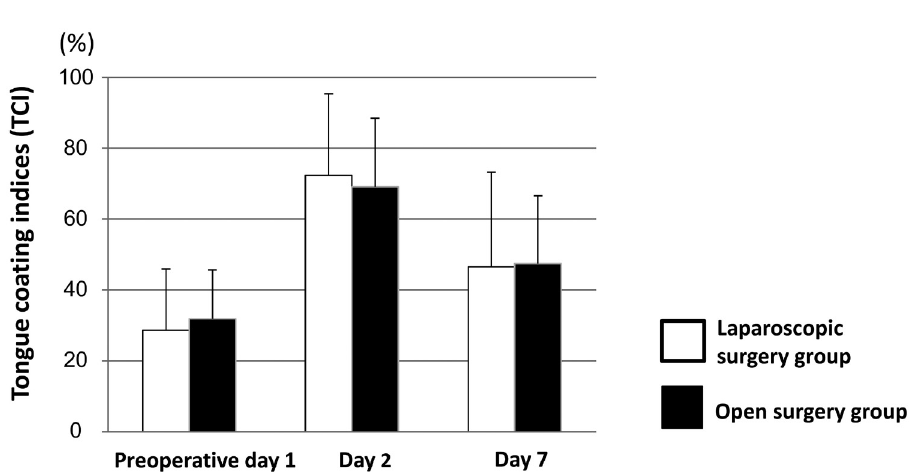
Figure 6- Comparison of tongue coating indices between laparoscopic surgery and open surgery groups. Error bars represent